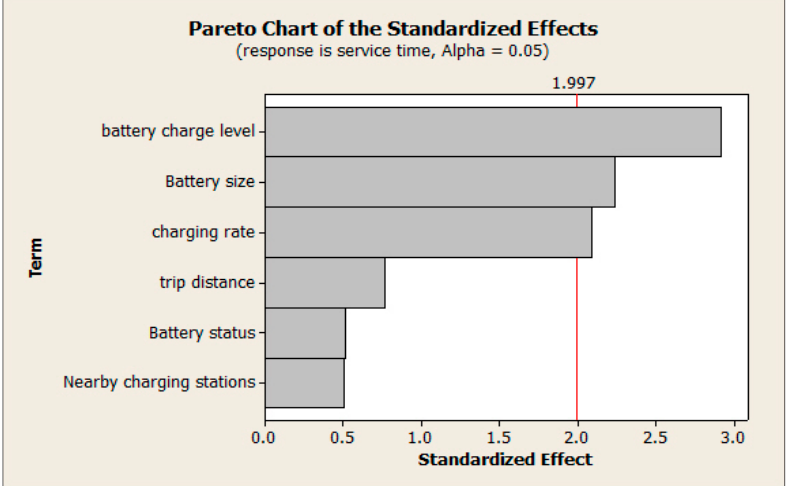
Figure 7. The significant factors on service span time.